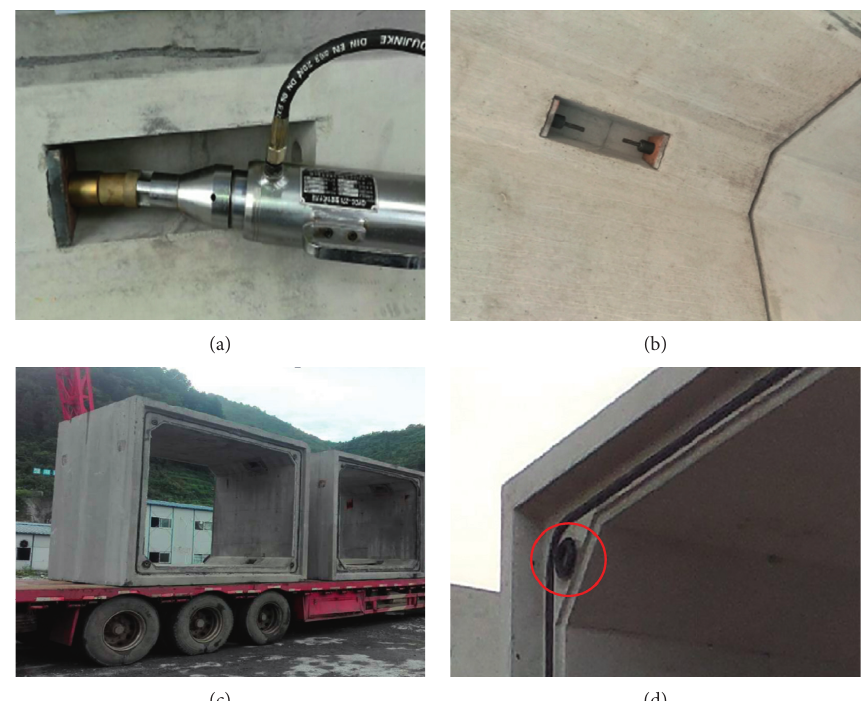
Figure 2: Photos of the utility tunnel segment and prestressed steel. (a) Prestress installation process. (b) Prestressed steel position. (c) Prefabricated utility tunnel. (d) Prestressed steel